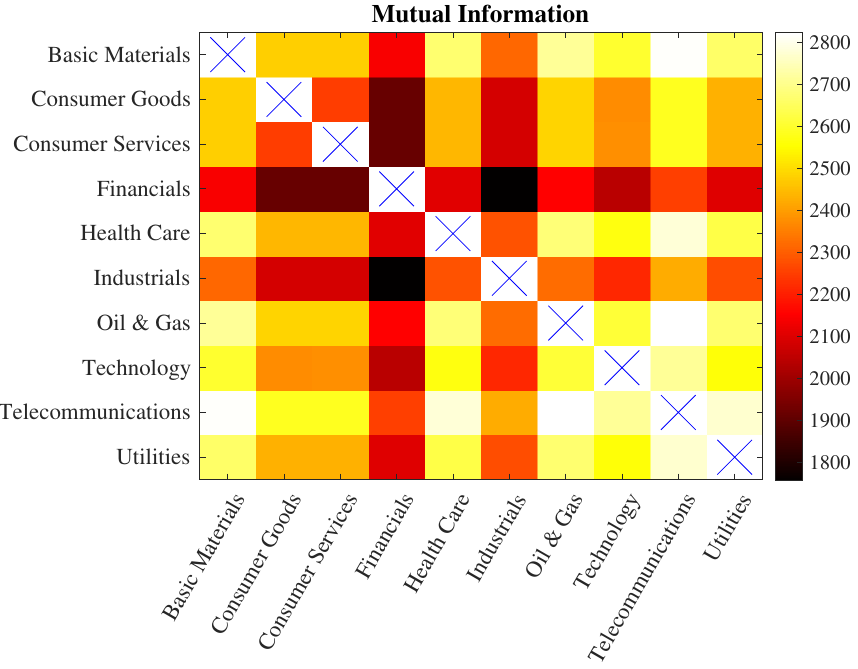
Figure 4. Intensity map for the mutual information, I ( X ; Y ) , between industry sectors.